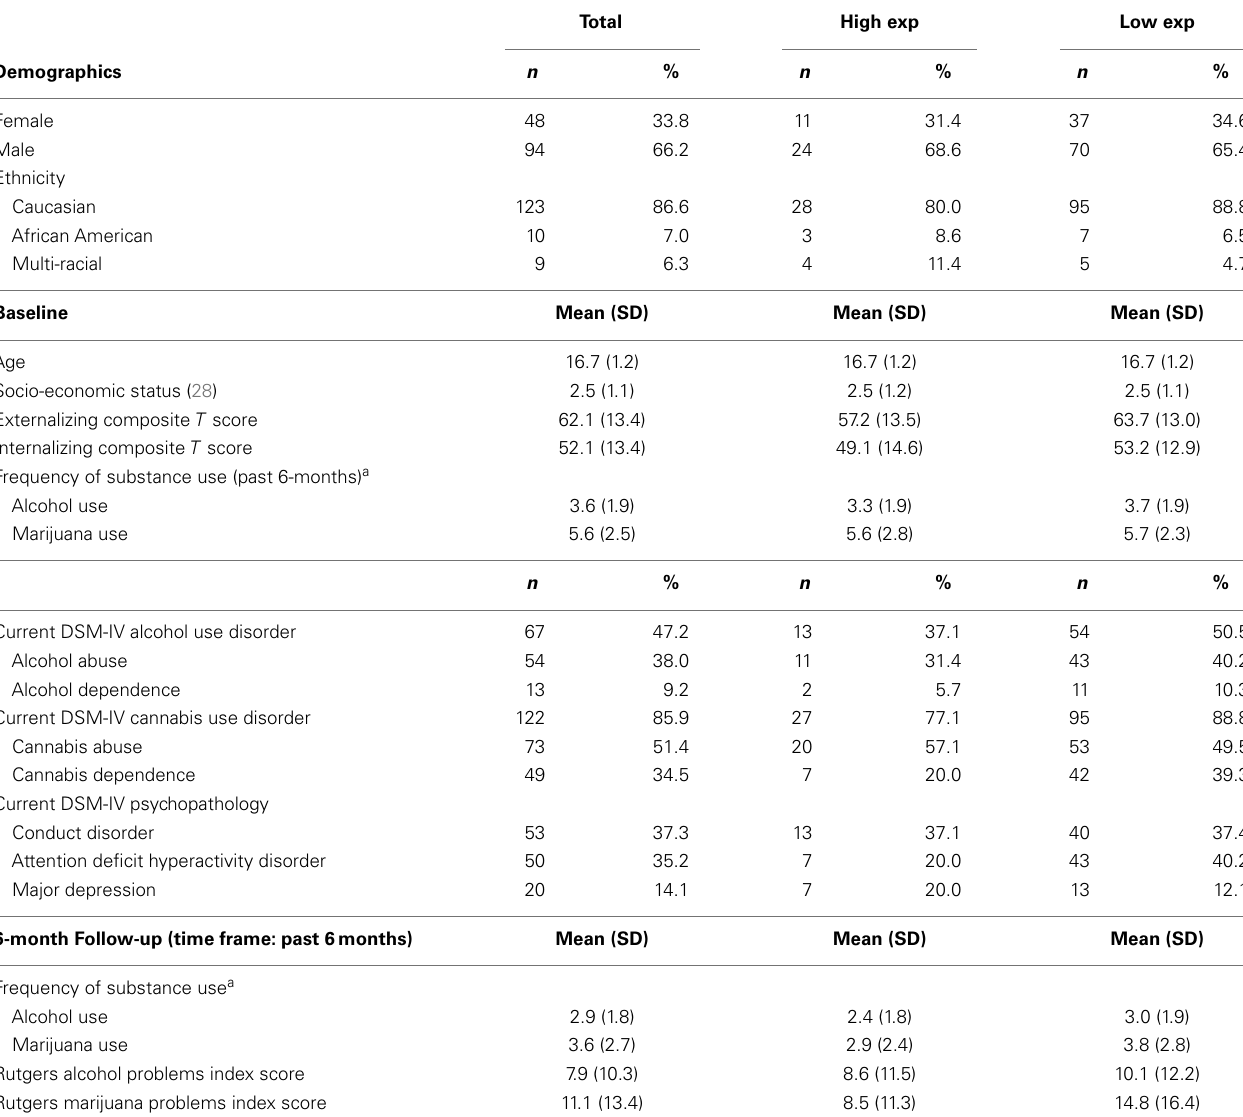
Table 1 | Descriptive statistics for the total sample, and high vs. low expressing allele groups